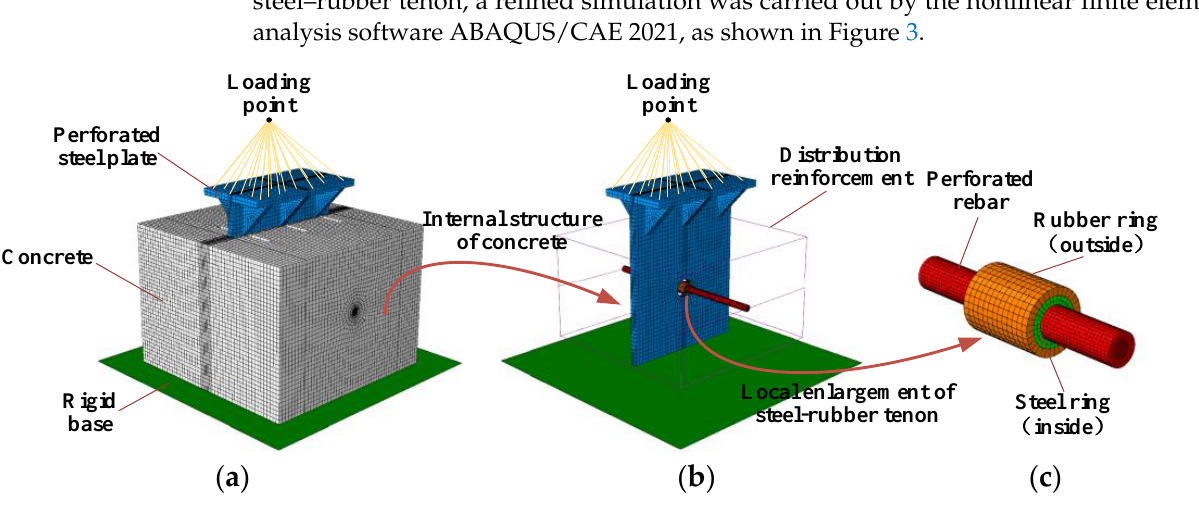
Figure 3. Finite element model and cell division: ( a ) overall model, ( b ) concrete internal structure, ( c ) partial construction with steel – rubber tenon.